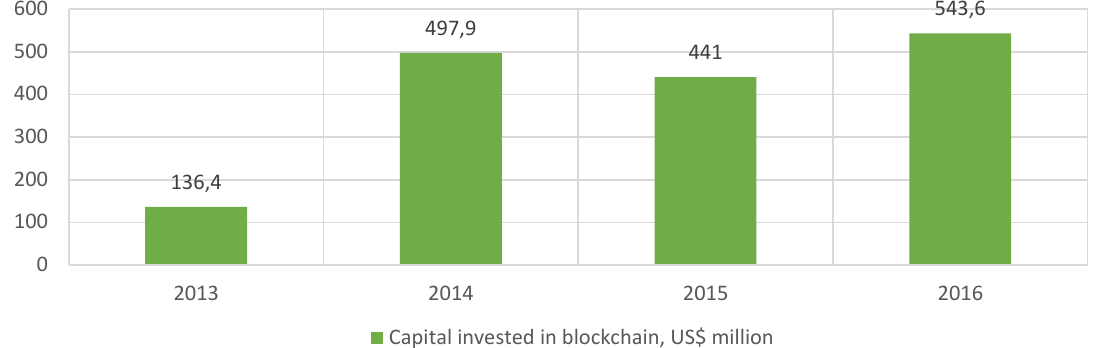
Figure 3. Investments in global blockchain FinTechs, US$ Table 1. The most successful FinTech in payment sector